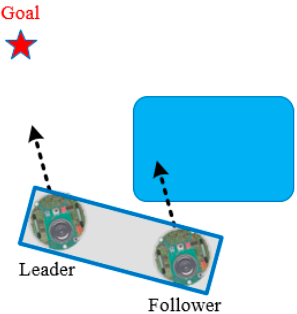
Figure 26. ( a ) Follower robot turns π − θ L ◦ ; ( b ) Pre-rotation process; ( c ) Manager mode of the two robots switch to the wall-following mode (WFM).